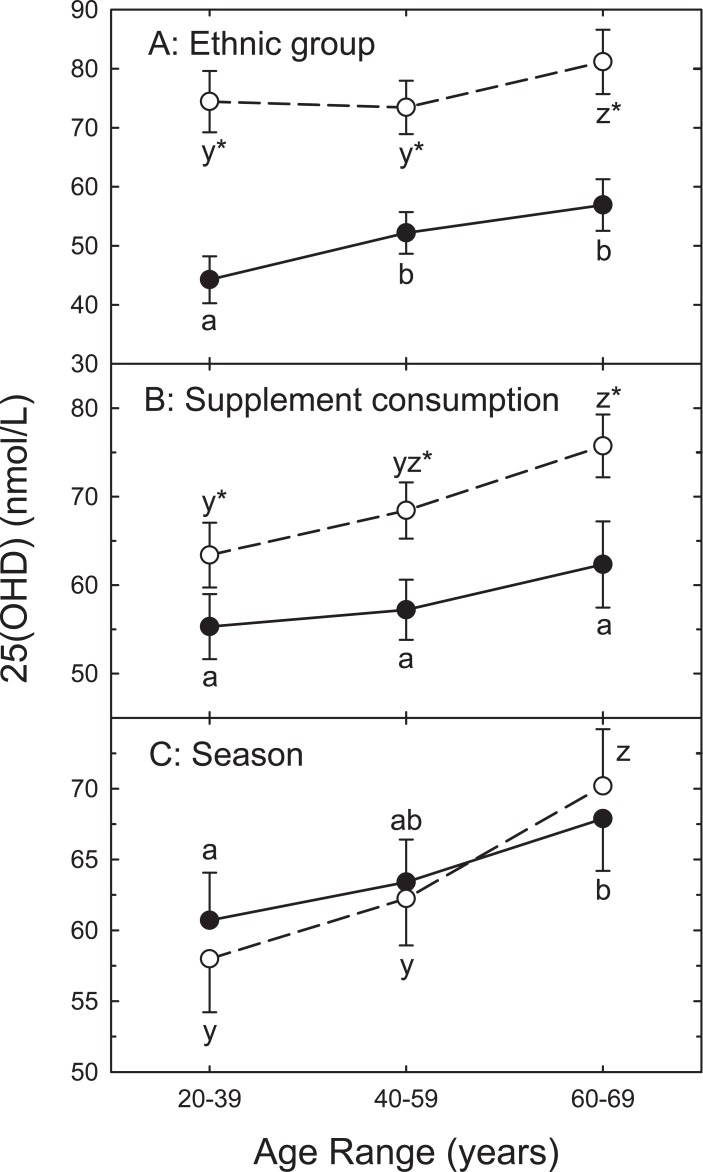
LSE serum 25OHD values with 95% confidence intervals as a function of ethnic background (A), vitamin D supplement consumption (B), and season (C) by age group. Panel A: values are for Europeans (open) or South Asians (filled). Panel B: those not consuming supplements (open) or supplement consumers (filled). Panel C: spring (open) or fall (filled). Superscripts (a,b,c,y,z) denote significant differences (P<0.05) when compared to other age ranges within South Asian (y, z) or European (a, b, c) ethnic groups. *Different from value for corresponding ethnic group (panel A), supplement status (panel B) or season (panel C; P<0.05).